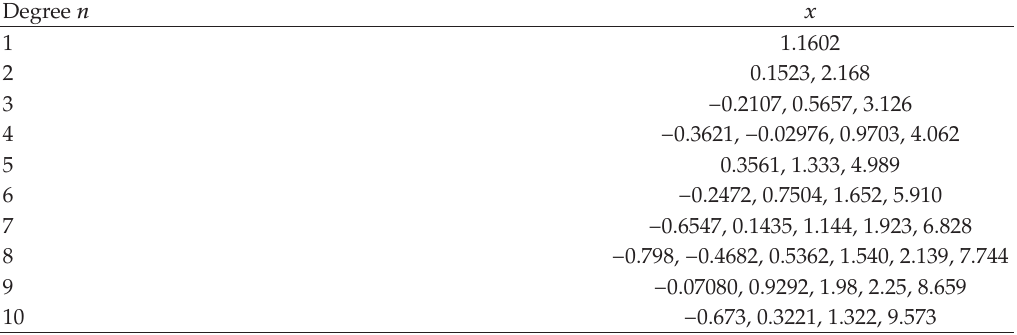
Table 3: Approximate solutions of G n, 1 / 3 (cid:2) x (cid:3) (cid:6) 0 ,x ∈ R